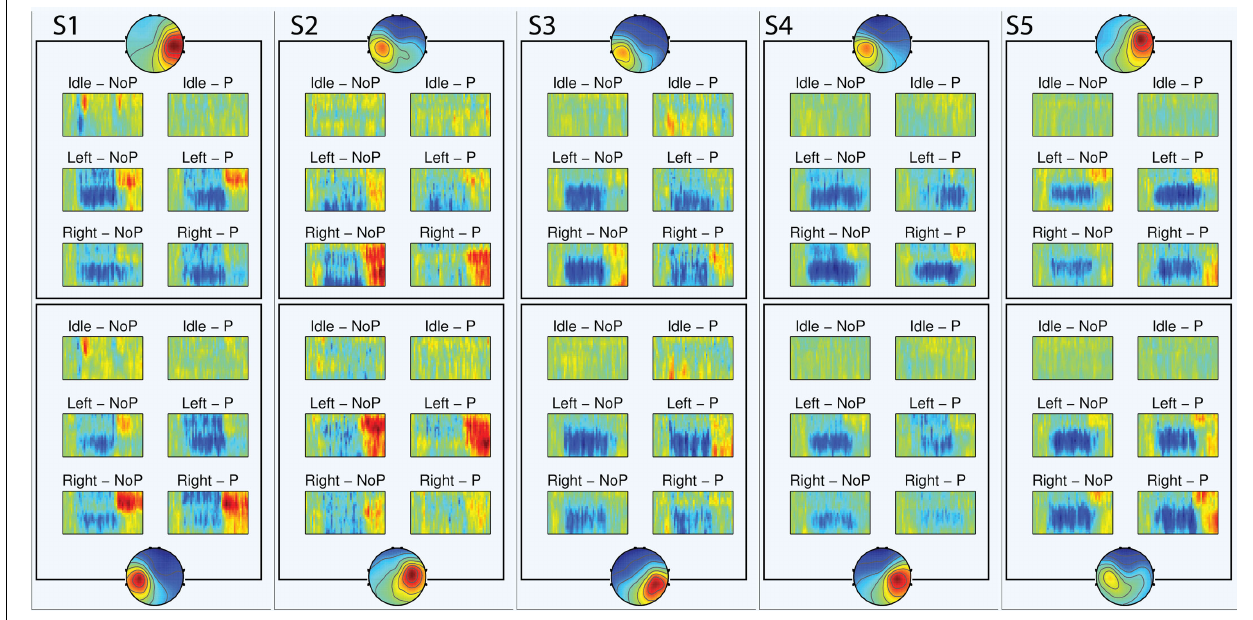
possible to compare the ERSP of NoPert (NoP) and Pert (P), while appreciating the features that characterize each class. To note that the ERD/ERS patterns are subjects-specific and informative for the classification. Moreover this representation do not highlight differences between the two conditions NoPert and Pert , confirming the quantitative results of the Z